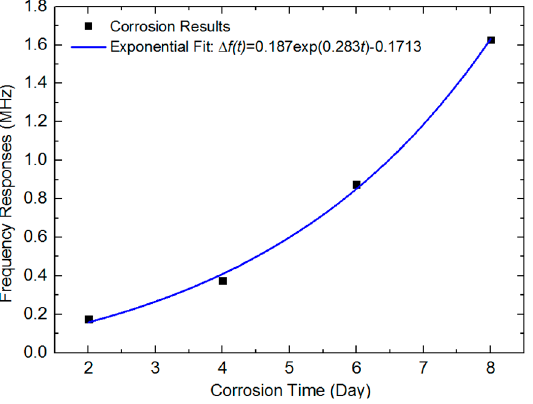
Figure 10. The frequency responses in four corrosion sections trendline estimates from corrosion time.